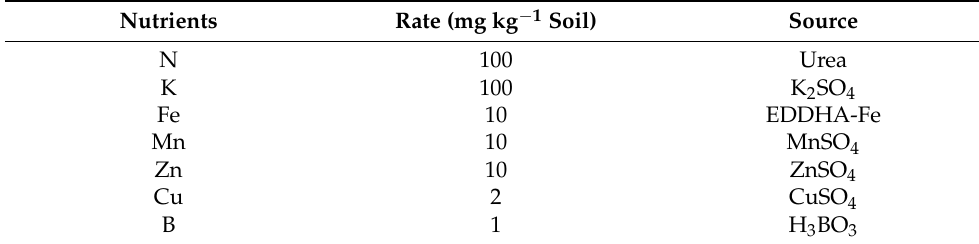
Table 3. Nutrients required based on soil test results.